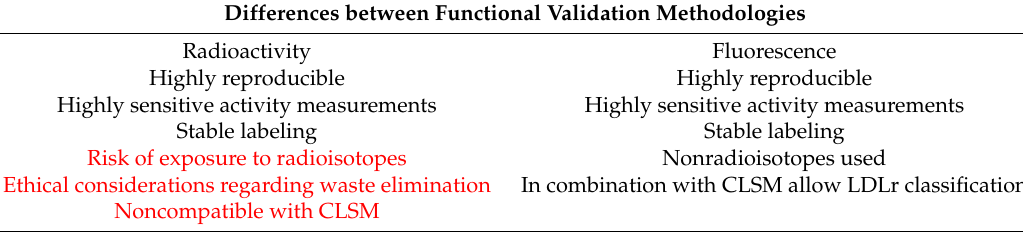
Summary of advantages and disadvantages of radioactive and fluorescence-based methodologies used to characterize the activity of LDLr